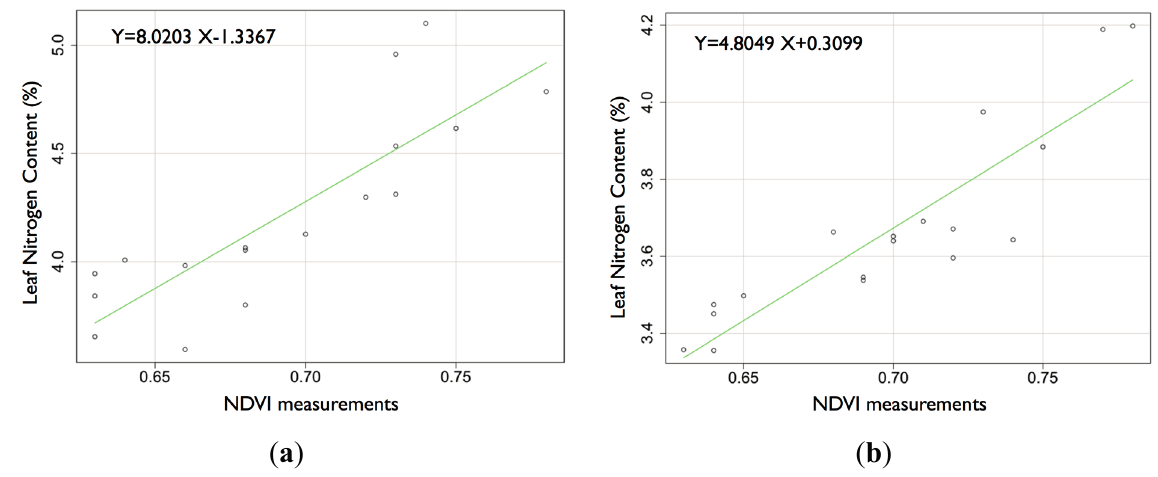
Figure 6. Relationship between the NDVI measurements and leaf N content (a) for field 1 and ( b ) for field